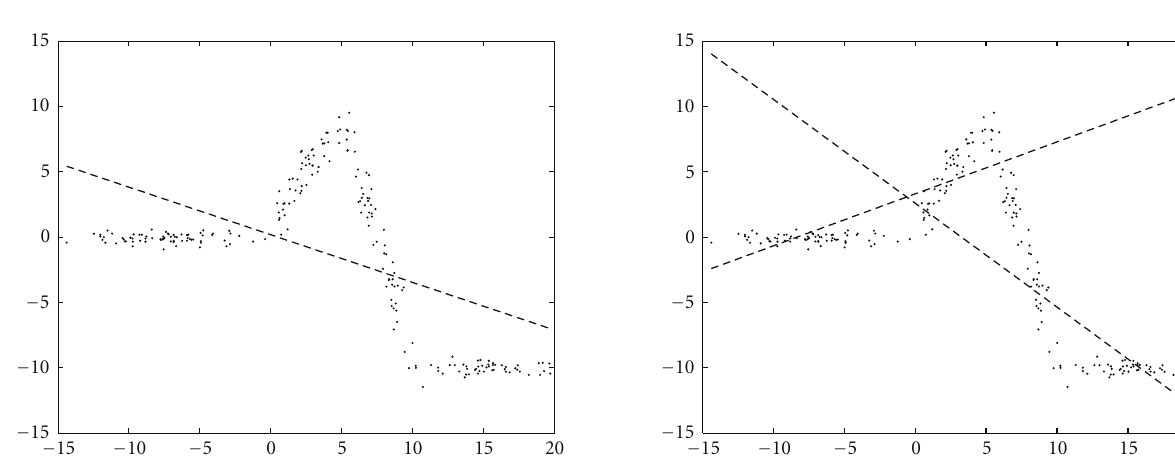
Figure 3: Final hyperplane (dashed line) estimated by the hyper- plane clustering in the case M = 1.